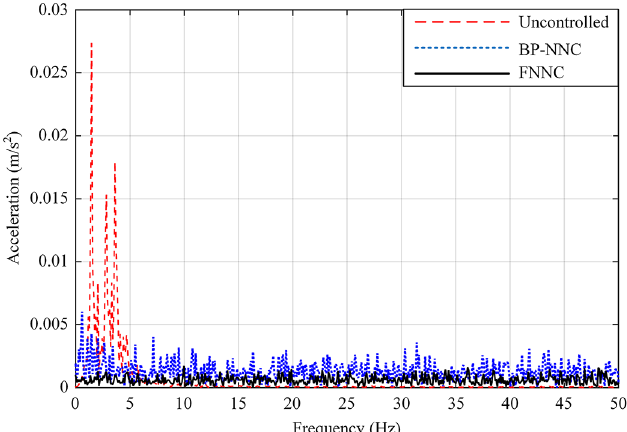
Fig. 23. Frequency-domain response of horizontal vibration acceleration of the elevator car with a medium load.